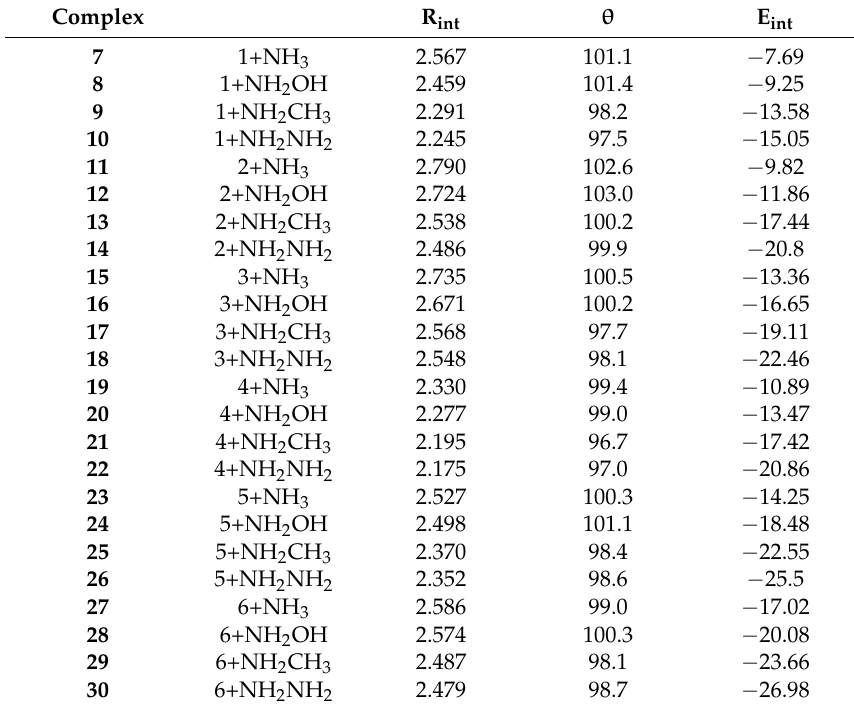
Table 3. Binding distances (R int , Å), C-M-H angles ( θ , ◦ ) and interaction energies (E int , kcal/mol) of the cationic tetrel-bonded